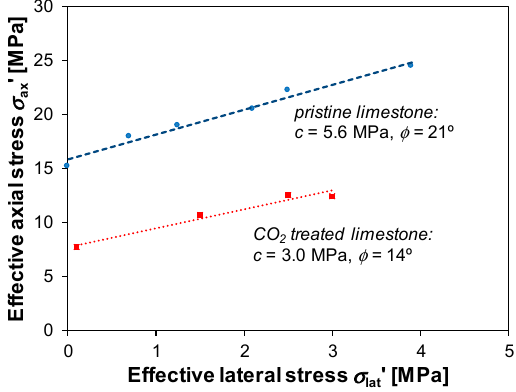
Figure 5. Effect of CO 2 injection on the geomechanical response of Apulian limestone tested in conventional triaxial compression at σ 3 ′ = 2.5 MPa.